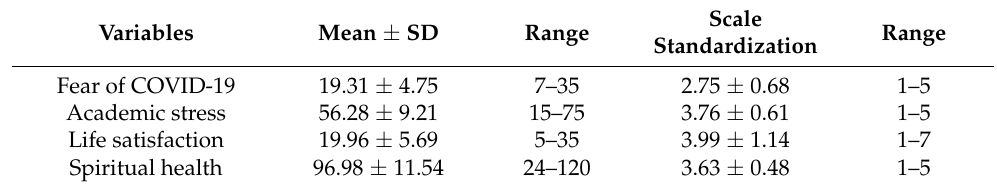
Table 2. Levels of main variables ( N =